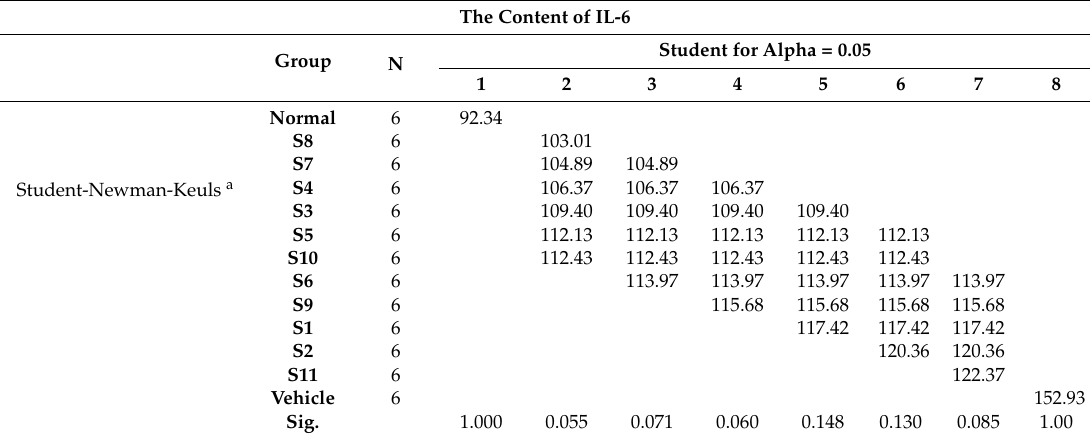
Table 6. Multiple comparison SNK test results of